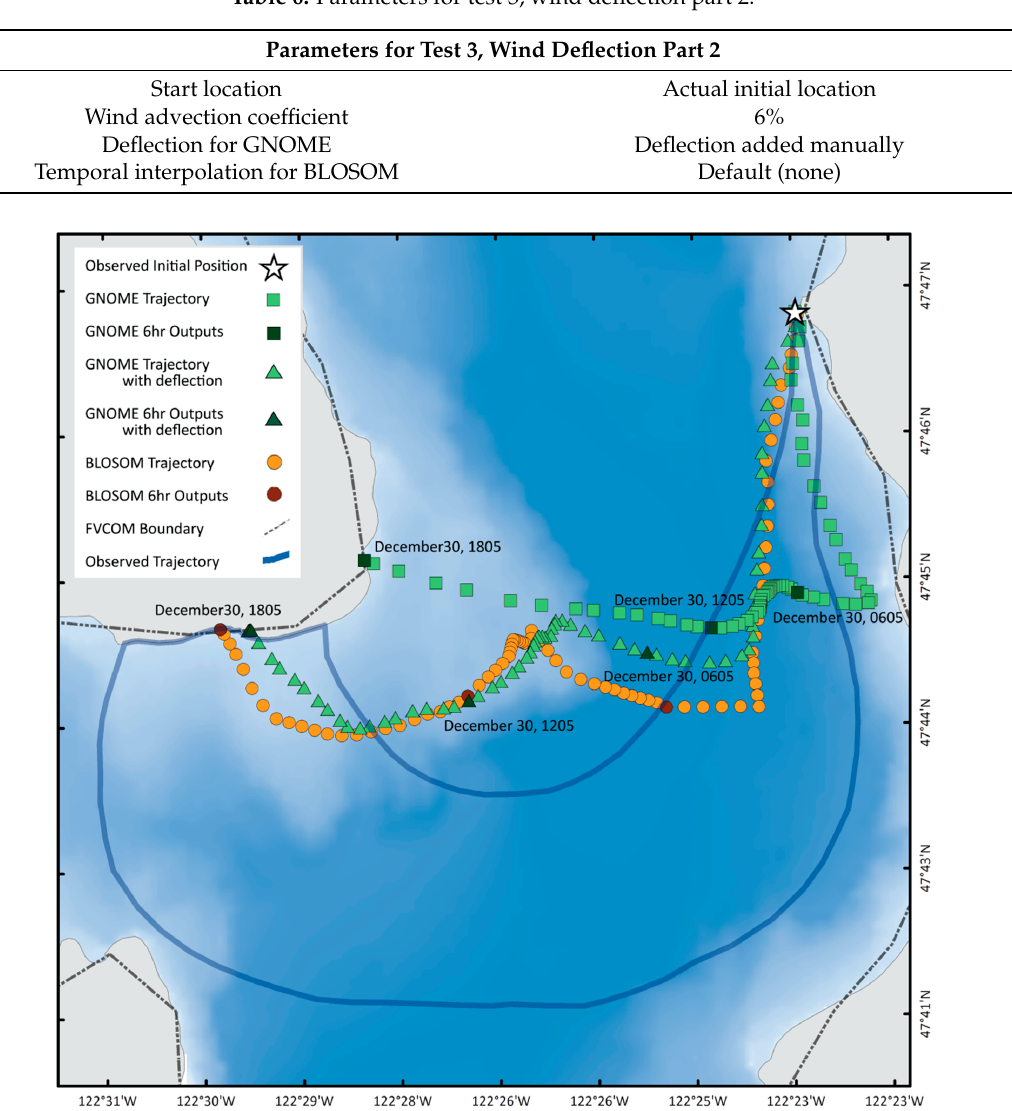
Table 7. Parameters for test 4, temporal